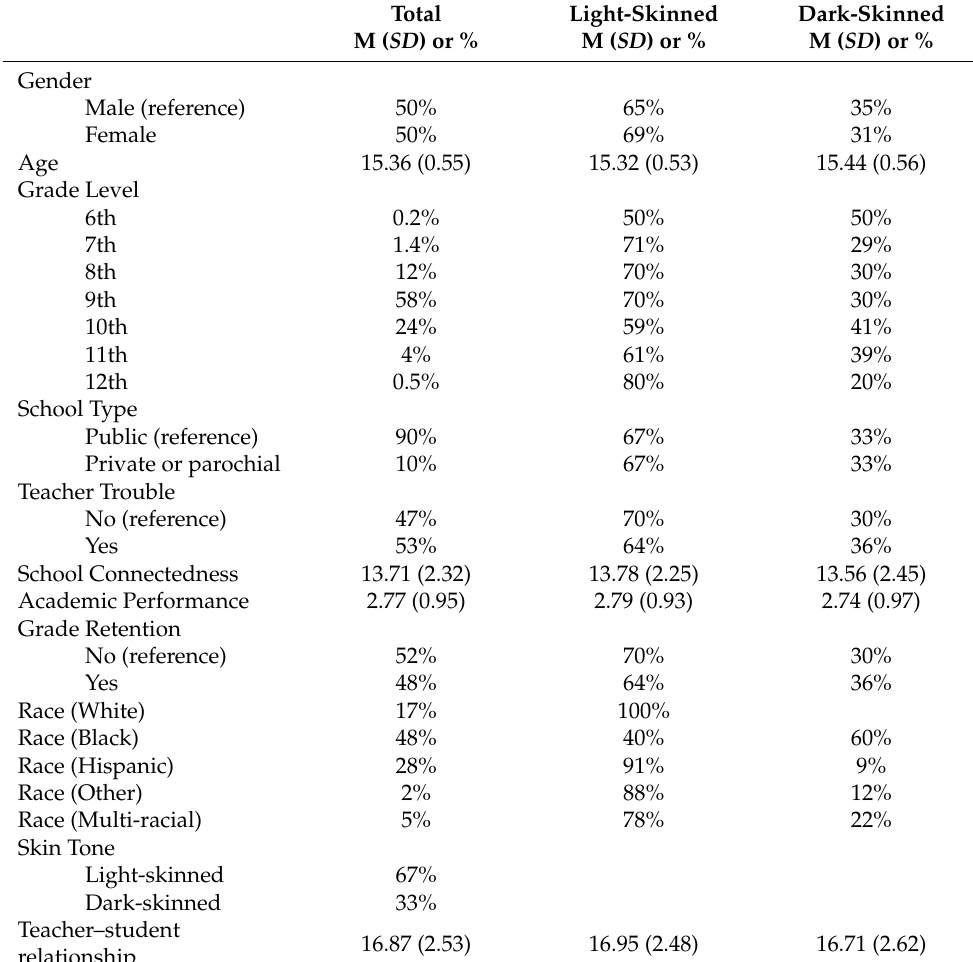
Table 1. Sample description ( n =